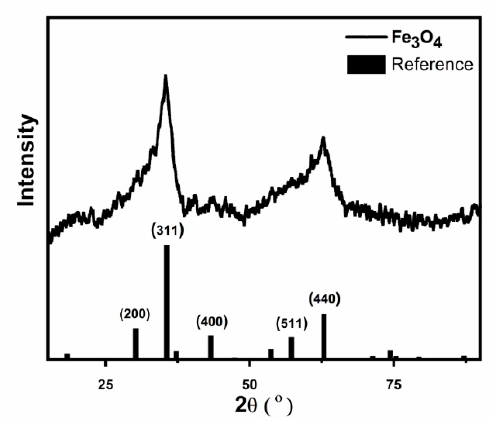
Figure 2. X-ray diffraction (XRD) analysis of Fe 3 O 4 nanoparticles and the reference pattern according to ICSD:250540 and ICDD:98-025-0540 [31].